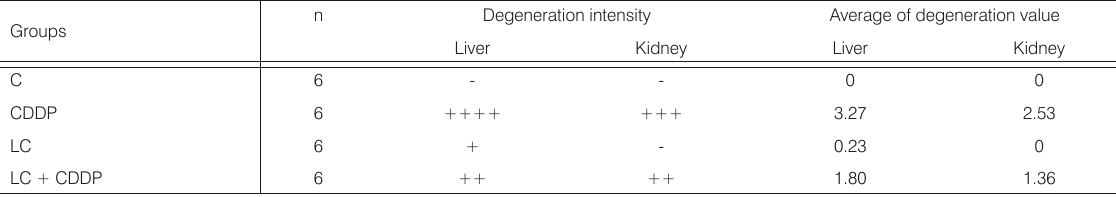
Table 2. Semiquantitaivy analysis of histopathological lesions in liver ad kidney of experimental groups.